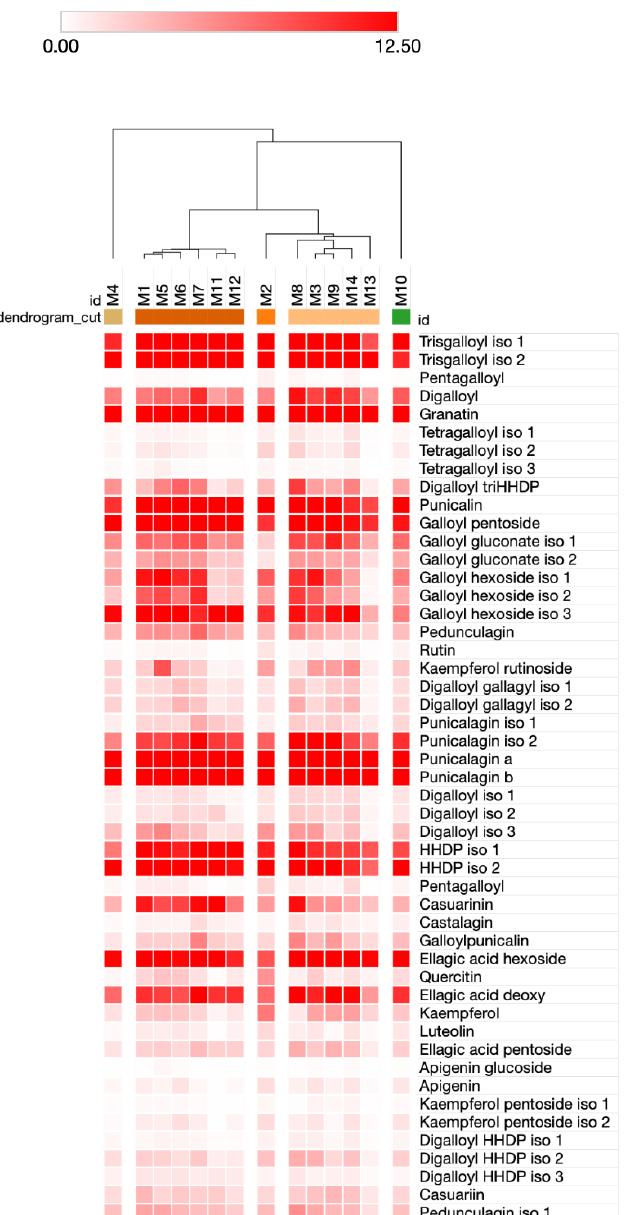
Figure 5. Hierarchical clustering (HCL) analysis of chemical data from peel pomegranate samples. HCL was calculated on columns by applying the One Minus Pearson correlation with the average linkage algorithm and evidencing the presence of specific clusters. Increasing intensity of the red color is directly proportional to compound intensity. The data represent, for each, LC-MS signal intensities and are expressed as average values/100,000,000.